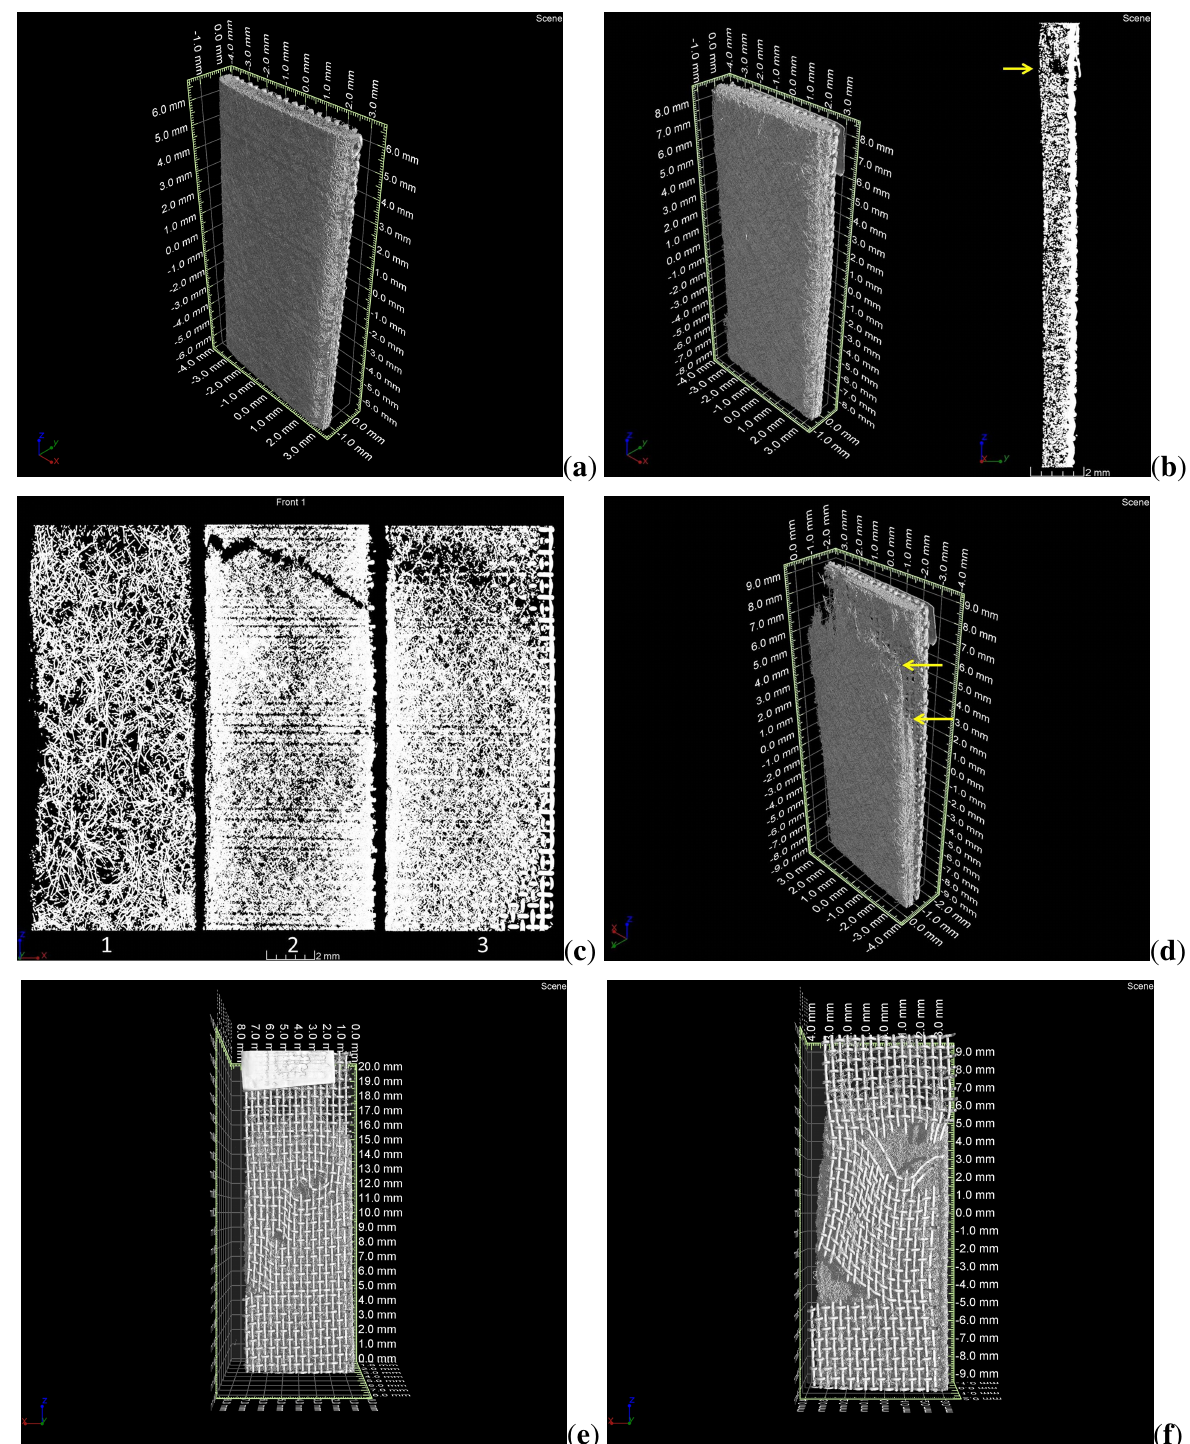
Figure 4. CT images of the SFF 3 tensile test sample. ( a ) three dimensional view before tensile tests; ( b ) three dimensional view and sectional view of the y-z-plane oriented parallel to the direction of loading after (cid:15) = 7% ; ( c ) sectional views of layer 1, 2 and 3 after (cid:15) = 7% ; ( d ) three dimensional view after (cid:15) = 12% ; ( e ) three dimensional view of the support grid after (cid:15) = 22% ; ( f ) three dimensional view of the support grid after (cid:15) = 37%